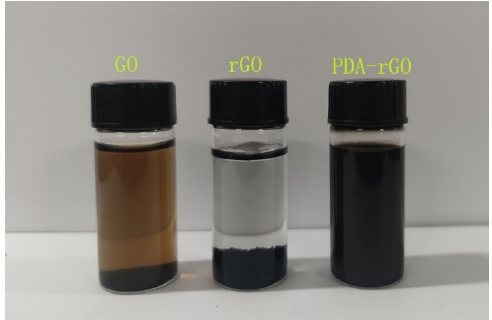
Figure 5. The optical photos of 1 mg/mL GO, rGO, and PDA-rGO solution after standing for 72 h.